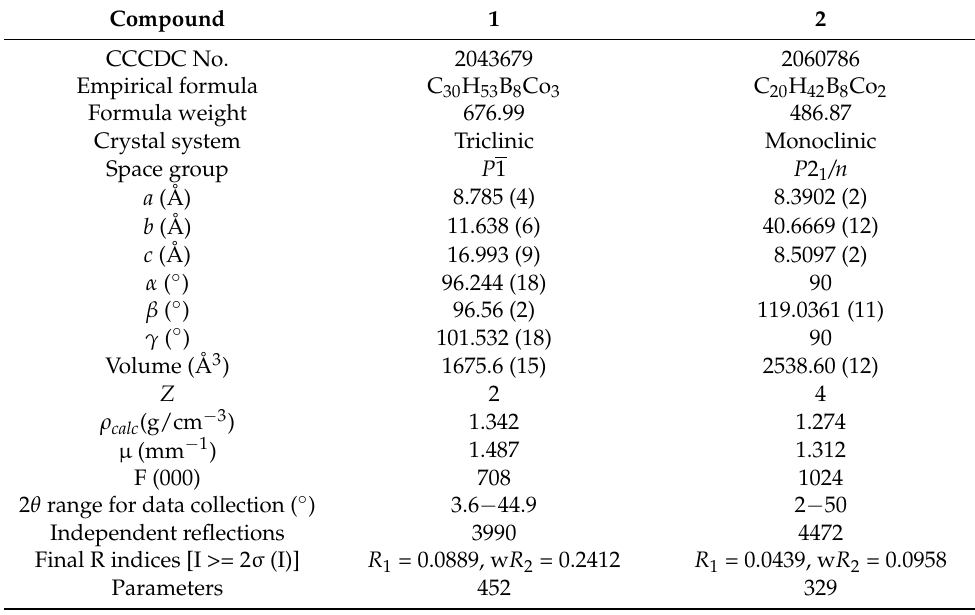
Table 3. Crystallographic and structural refinement data for 1 and 2